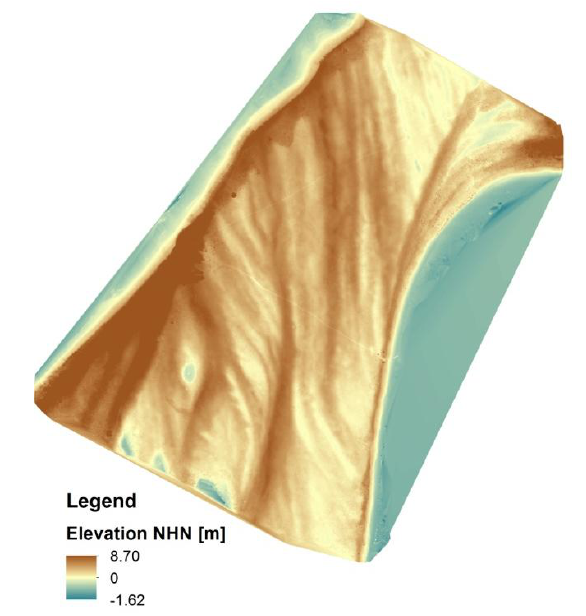
Figure 8. DSM of the bird reserve island Langenwerder